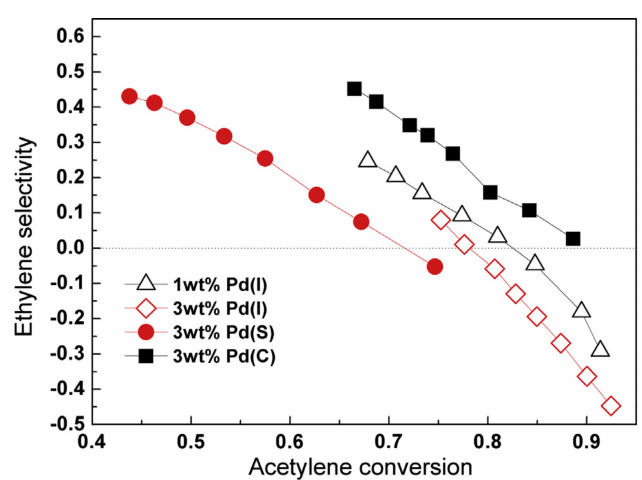
Figure 6. Ethylene selectivity as a function of acetylene conversion. Pd(I)-catalysts without defined morphology prepared by using the incipient wetness impregnation; Pd(S)-catalyst with spherical particles; Pd(C)-catalyst with cubic particles. Negative ethylene selectivity indicates net loss of ethylene due to over-hydrogenation and ethane production (reproduced with permission from [249]. Copyright